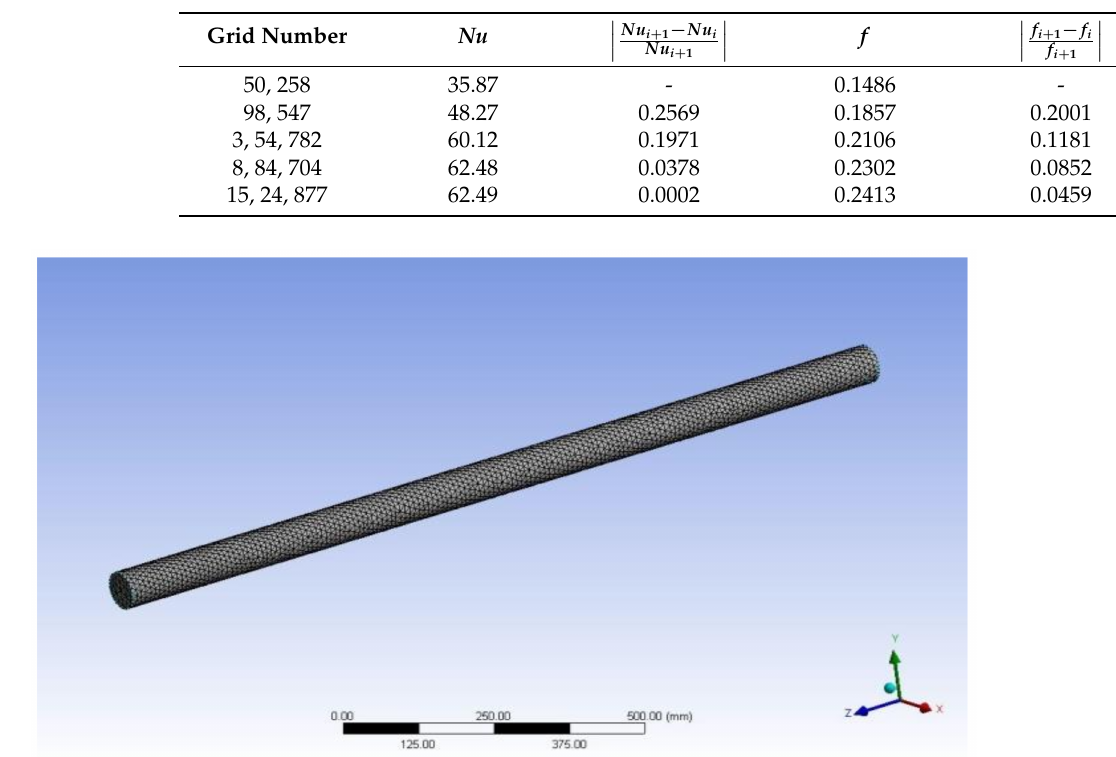
Table 2. Grid independence test.